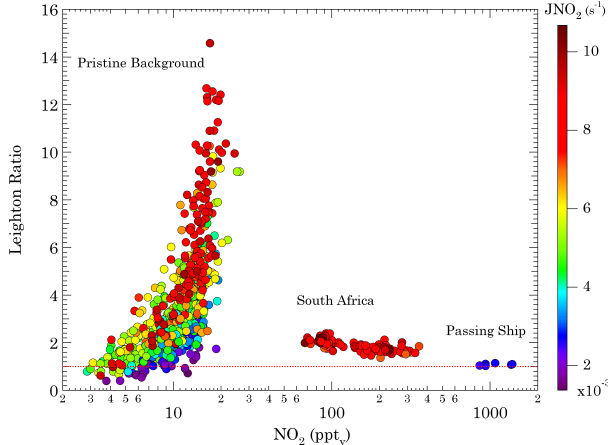
Table 4. Total uncertainty of the instrumentation.